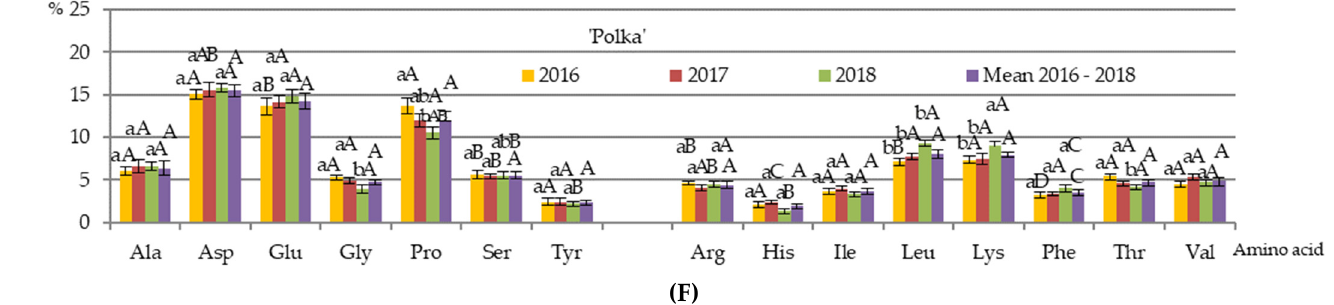
Figure 4. ( A – F ). Total amino acid profiles in the six R. idaeus cultivars analyzed in the three study